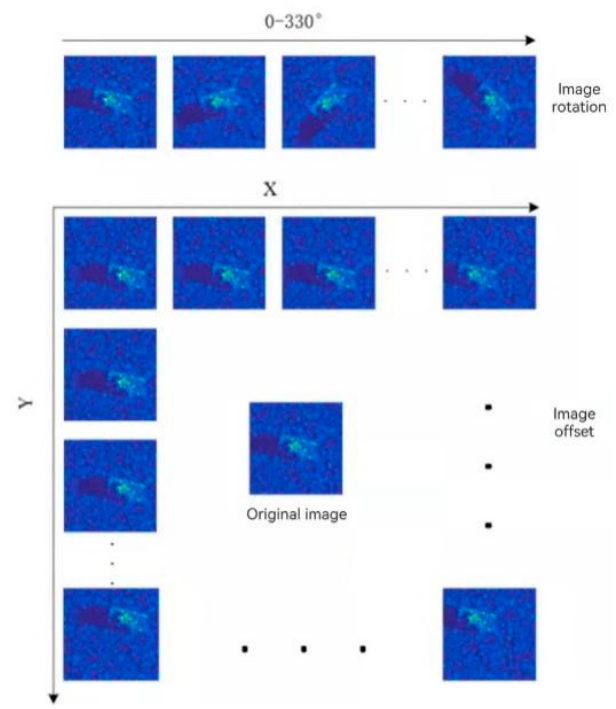
Figure 4. Dataset augmentation operation.